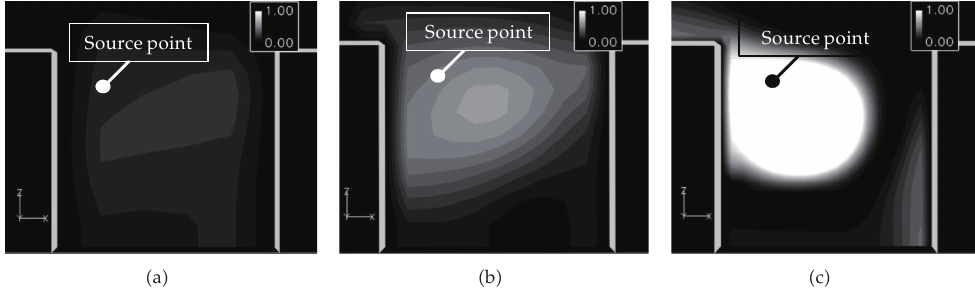
Figure 5: Reverse analysis results (cid:3) tU b /H b (cid:7) 200 (cid:4) : (cid:3) a (cid:4) Case 1-1, (cid:3) b (cid:4) Case 2-1, and (cid:3) c (cid:4) Case 3-1.